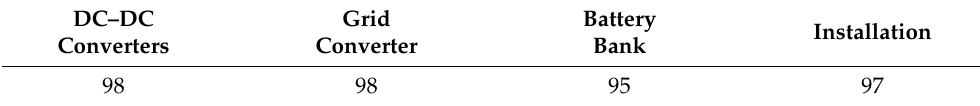
Figure 3. Scaled PV-BESS Scheme. Table 1. Energy Storage System Component Efficiencies